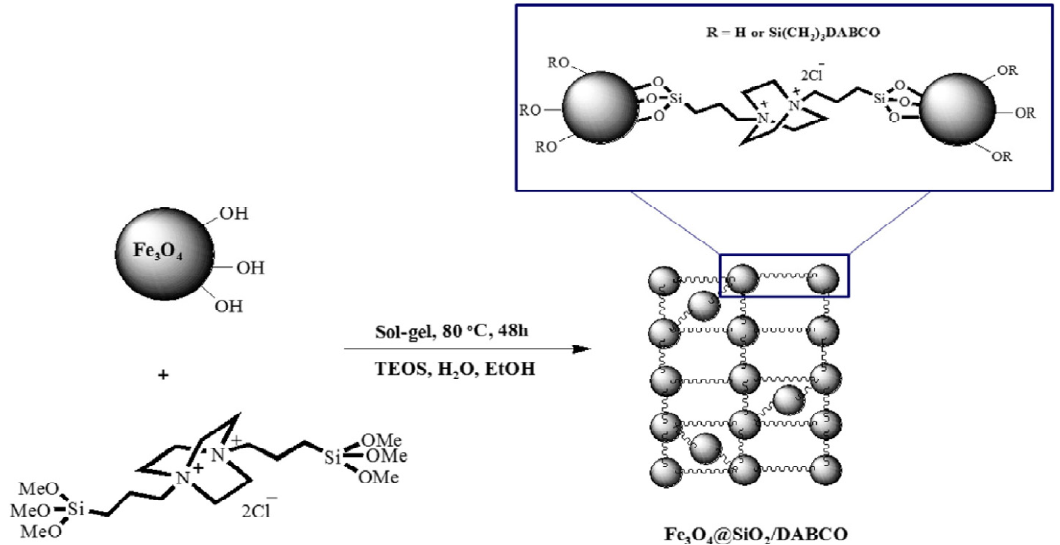
Figure 7. Synthesis of Fe the creation of a silica matrix. Reproduced from Kiasat et al. [66]. Copyright 2013 with permission of Elsevier.